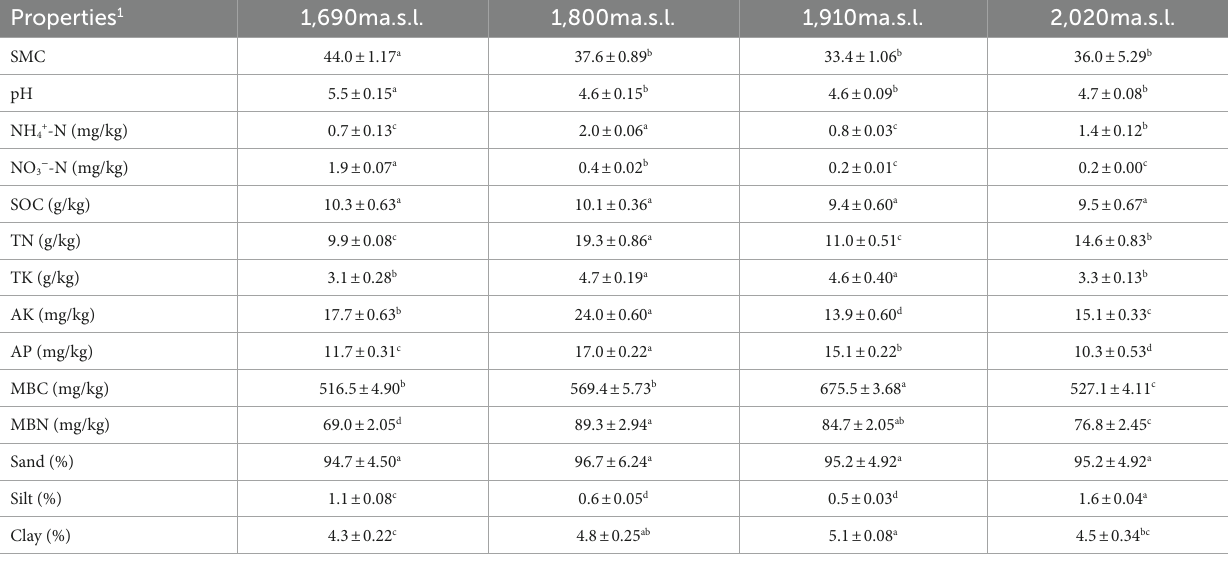
TABLE 1 Soil physicochemical characteristics along an elevational gradient on the Changbai Mountains, northeastern China. Properties 1